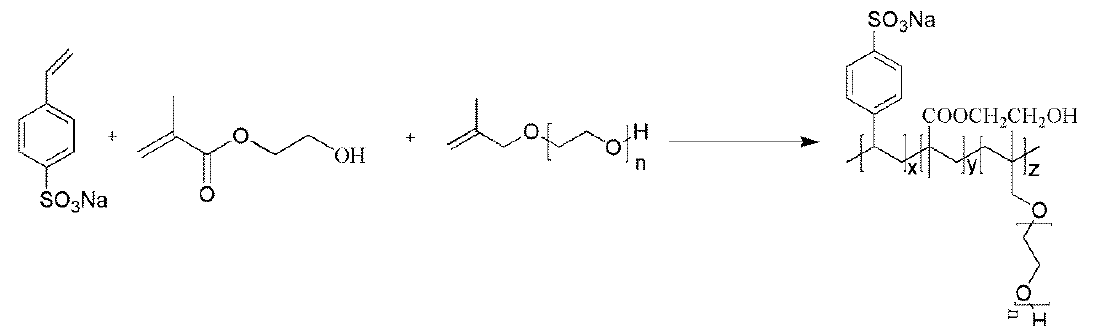
Figure 2. Synthetic route of the polysulfonate dispersant.